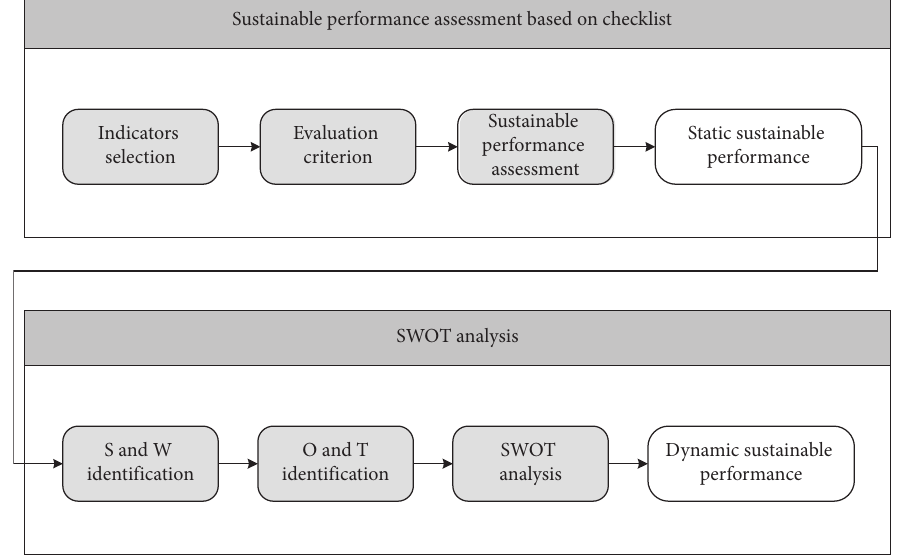
Figure 3: Conceptual framework of the integrated hydropower sustainability